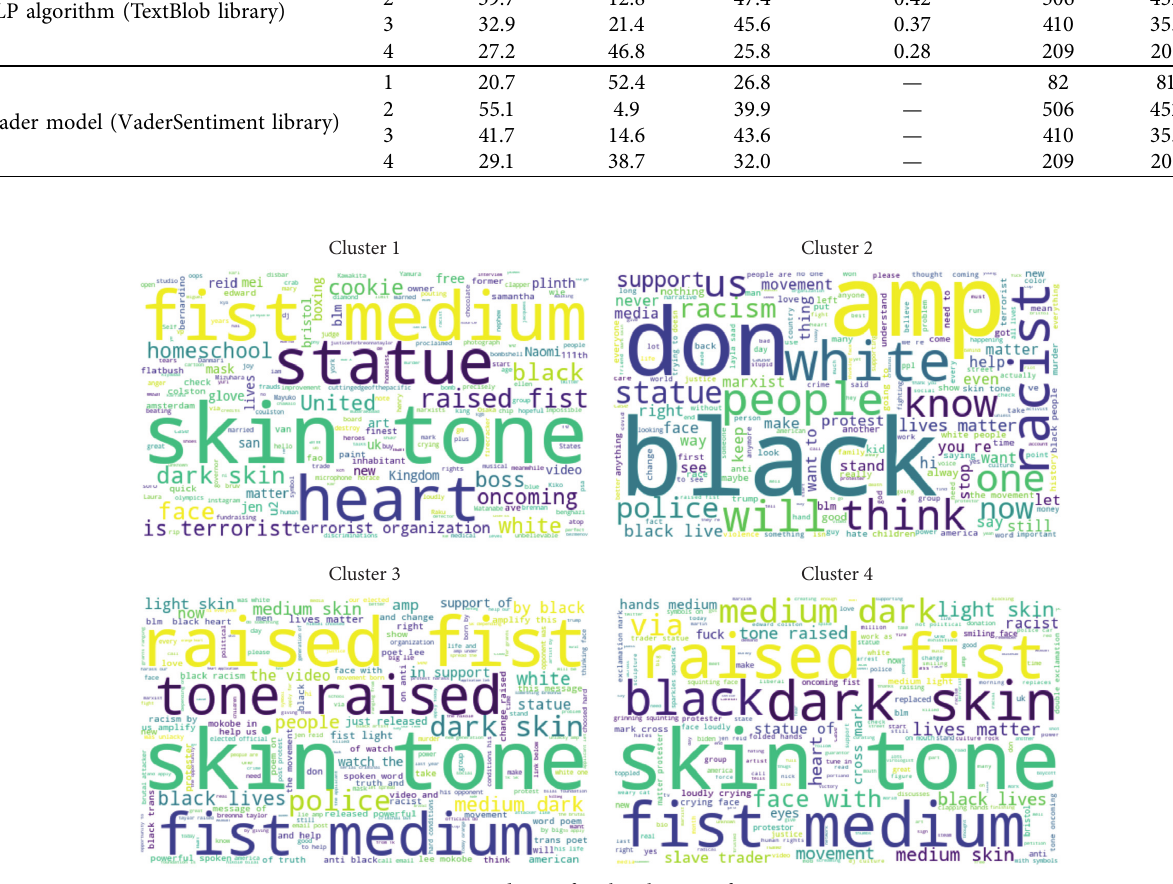
Figure 9: Word map for the clusters of Scenario 2.